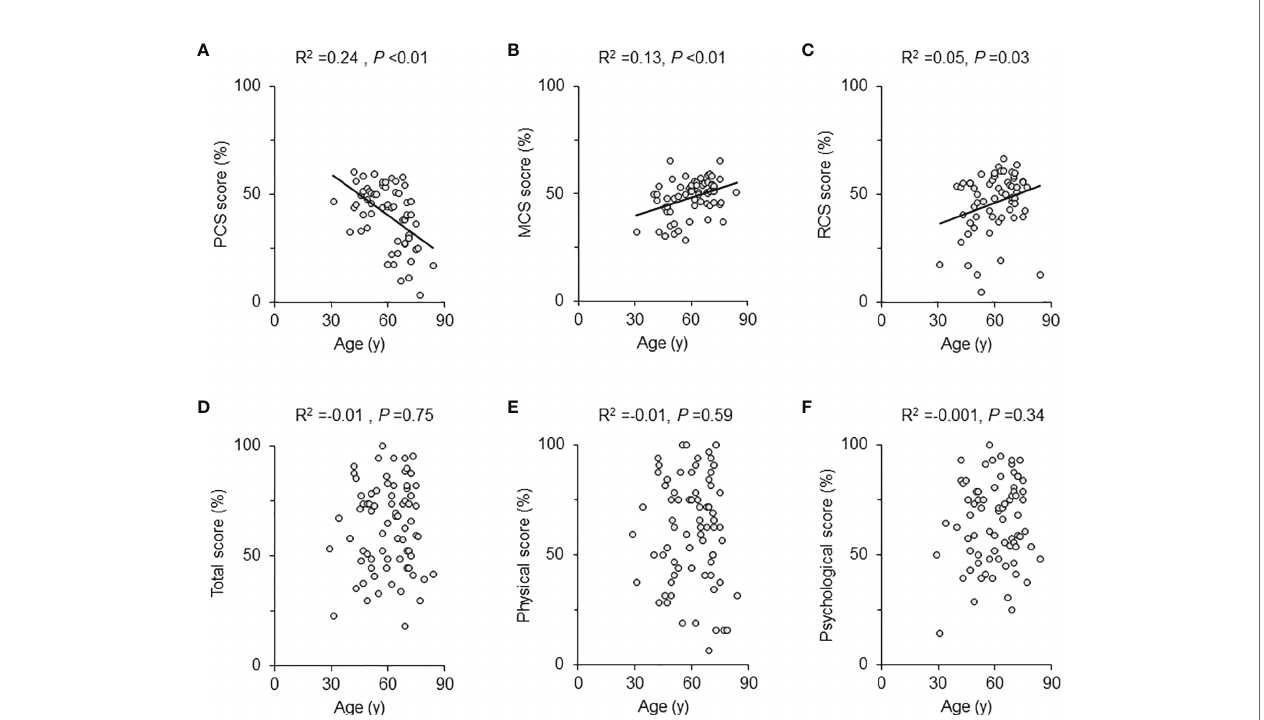
FIGURE 1 | Scatter plot and univariate regression analysis for QoL scores and age. The univariate regression analysis results for the SF-36 scores and age of all patients were shown with scattered plots for each scale: (A) physical component summary (PCS) score, (B) mental component summary (MCS) score, and (C) role/ social component summary (RCS) score. The AcroQoL scores of all patients are presented as follows: (D) total score, (E) physical score, and (F) psychological score. The solid lines are approximate straight lines. The adjusted R 2 and P -values are shown in each fi